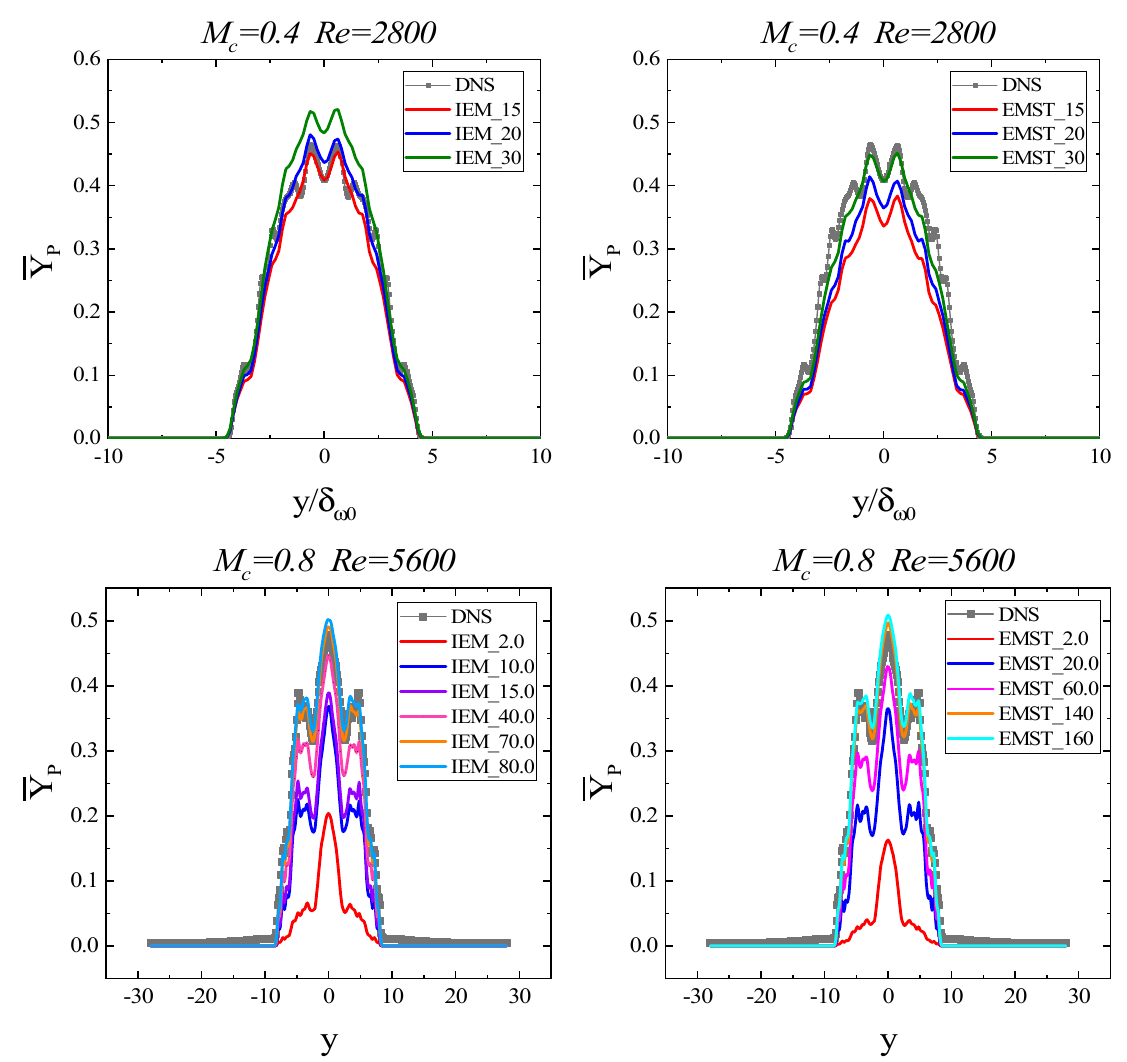
Figure A1. Cross-stream profiles of Reynolds-averaged values of the product mass fraction under different C φ : mass fraction calculated by FMDF-IEM for M c = 0.4 case, mass fraction calculated by FMDF-EMST for M c = 0.4 case, mass fraction calculated by FMDF-IEM for M c = 0.8 case, mass fraction calculated by FMDF-IEM for M c = 0.8